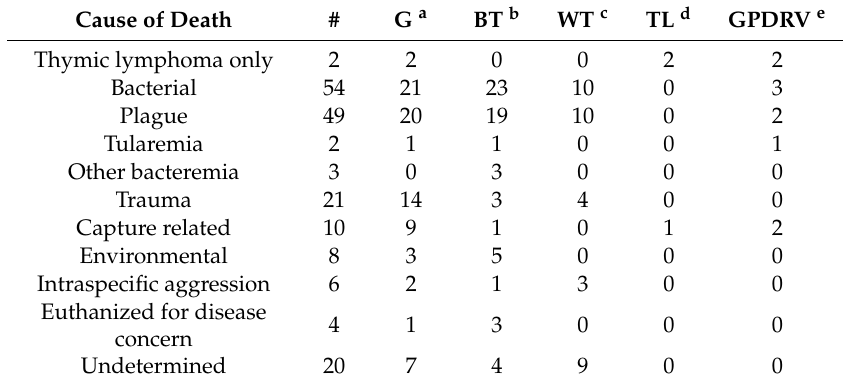
Table 2. Causes of death in 125 prairie dogs in Colorado from 2009 to 2018. Cause of Death # G a BT